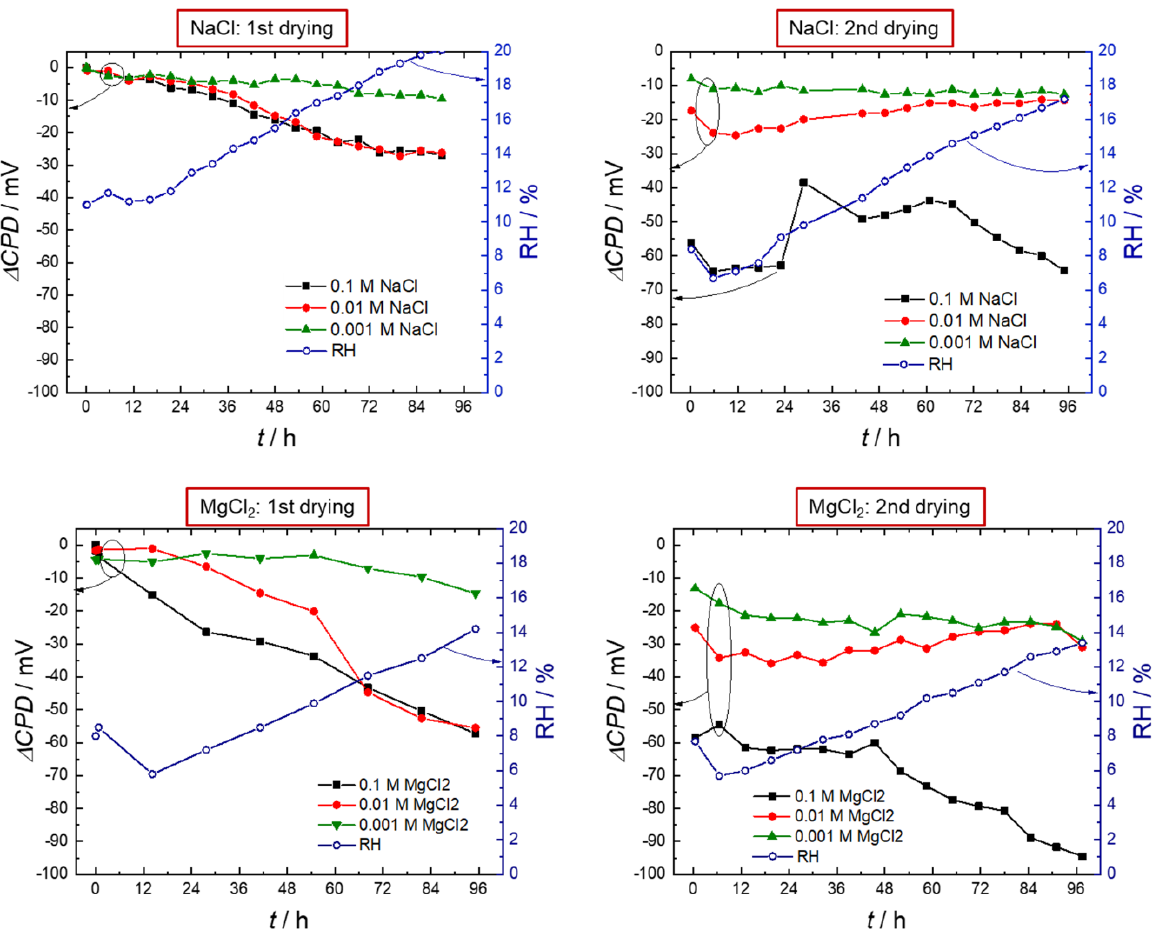
Figure 4. CPD changes at position of maximum hydrogen concentration (CPD minimum) over time during first and second drying interval and RH values recorded in the SKP chamber.